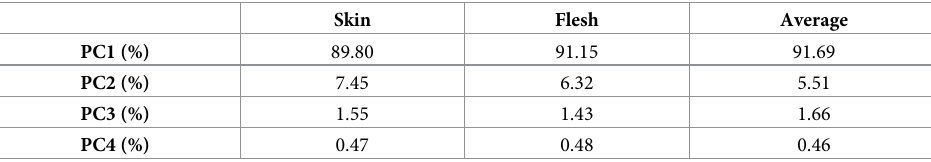
Table 1. The proportion of each principal component in the cumulative